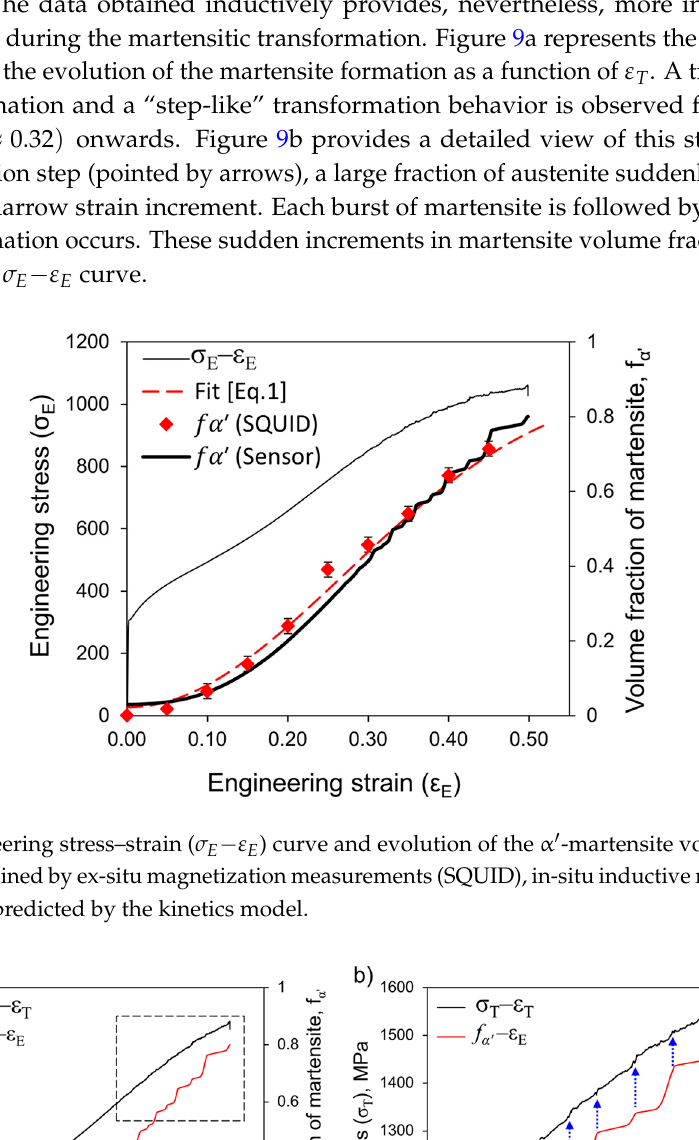
with ε T obtained in-situ by using αʹ